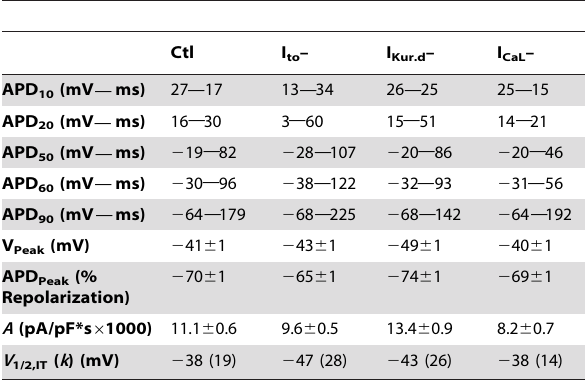
Table 3. Characteristics of the Atrial APs Used for AP-Clamp and the Corresponding I HERG in the Presence of Varying K + Channel Blockers to Inhibit I to , I Kur or I CaL .